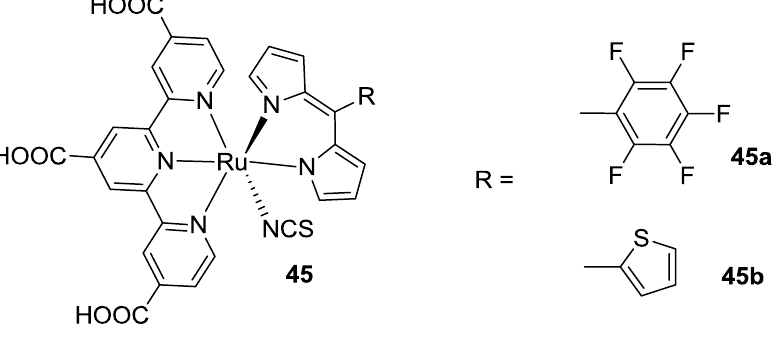
Figure 36. 2,2’-Dipyrromethane by Li et al. [146].